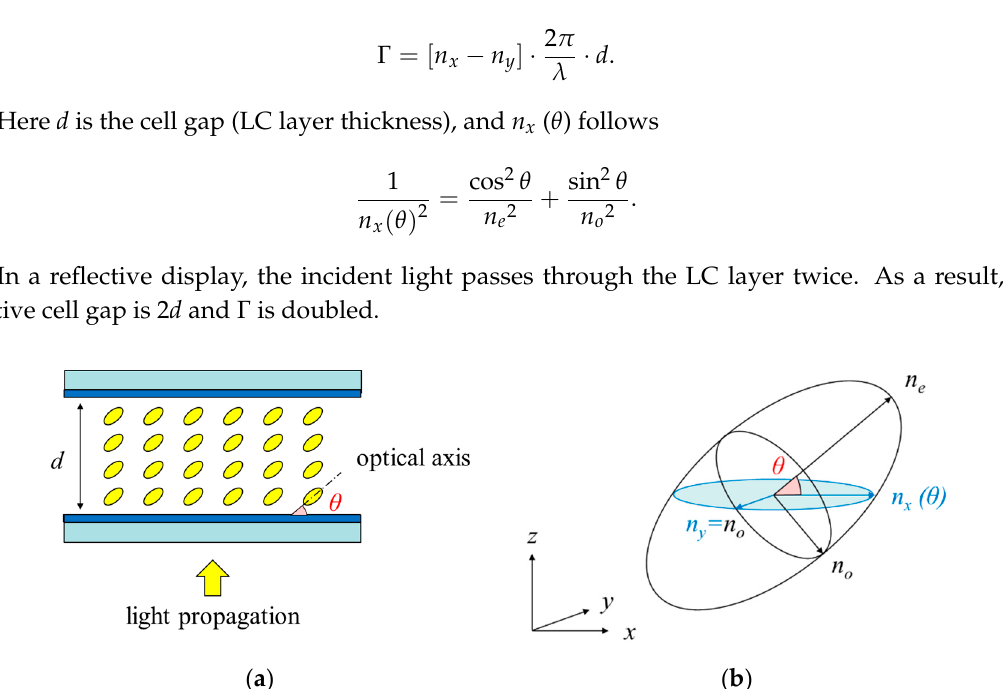
Figure 2. ( a ) The schematic structure of an LCoS phase retarder. ( b ) Refractive index ellipse of a uniaxial liquid crystal.